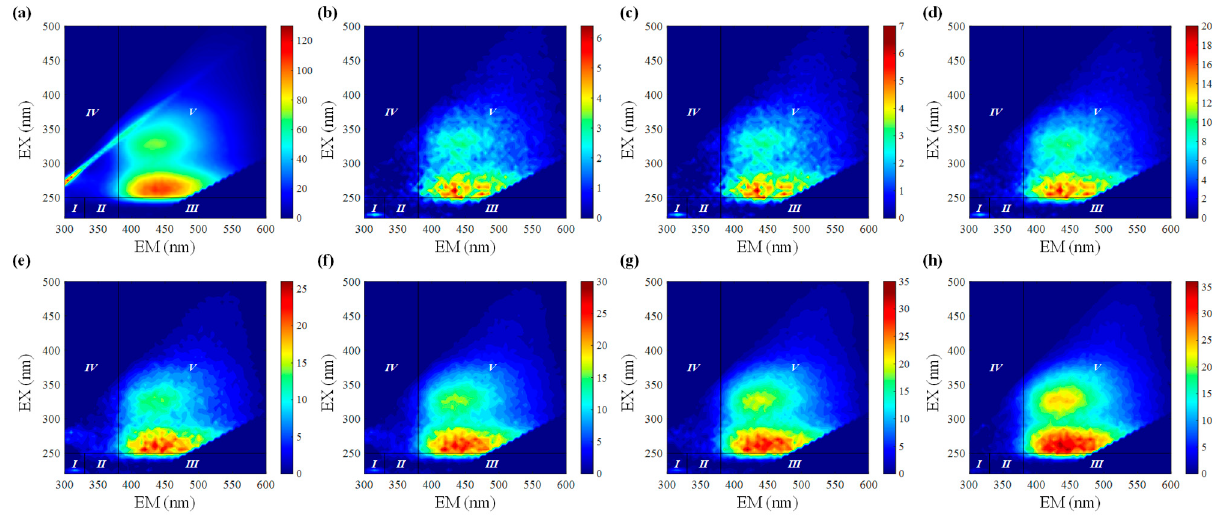
Figure 2. Δ EEMs of PPFA binding with Fe(III) and fluorescence region integration (FRI) results with the addition of iron: ( a ) 0 μ mol·L − 1 ; ( b ) 1.75 μ mol·L − 1 ; ( c ) 4.50 μ mol·L − 1 ; ( d ) 6.50 μ mol·L − 1 ; ( e ) 9.00